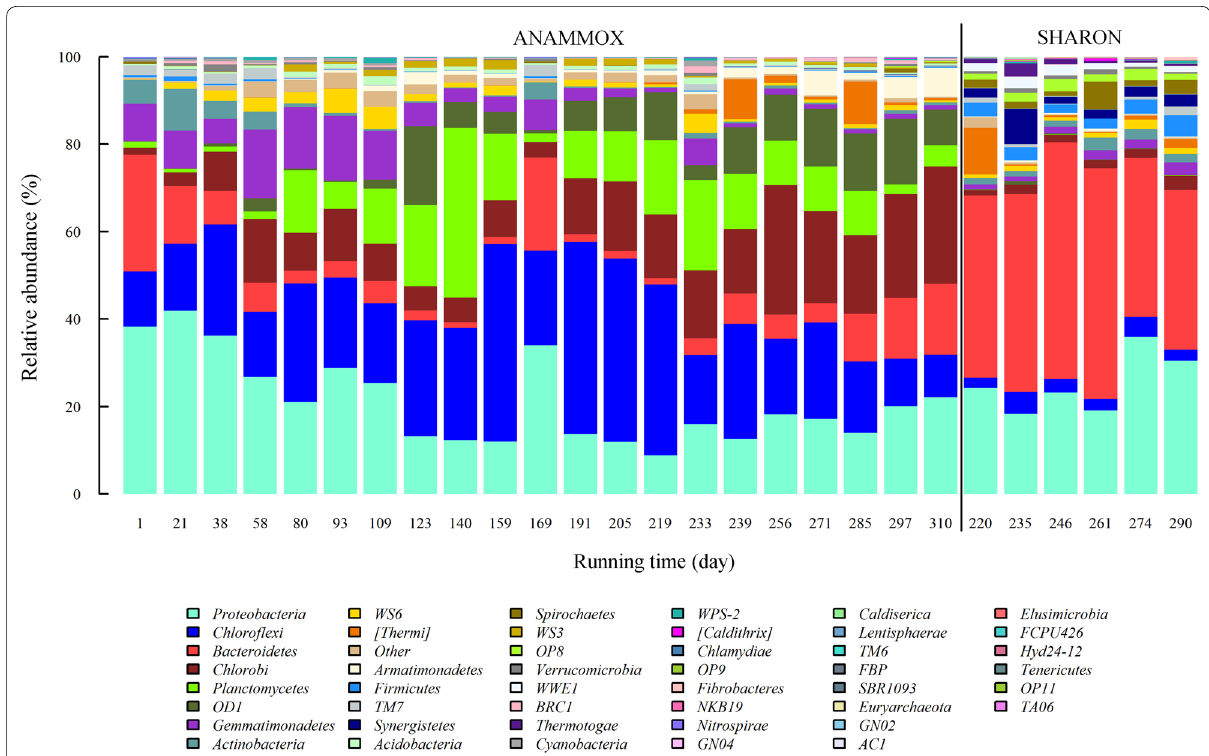
Fig. 2 Relative abundance of phyla based on Illumina MiSeq bacterial 16S rRNA genes in ANAMMOX samples during the entire running period, and in SHARON samples when SHARON effluent was used as ANAMMOX influent